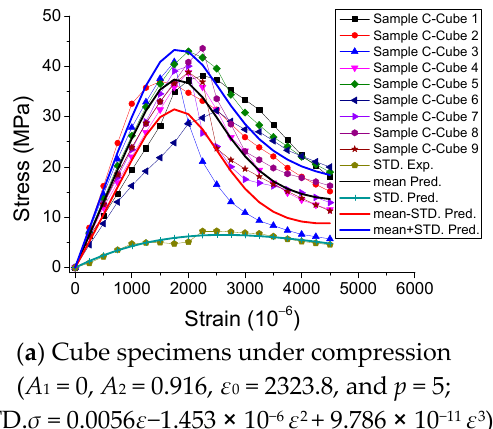
Sample C-Prism 4 Sample C-Prism 5 Sample C-Prism 6 Sample C-Prism 7 Sample C-Prism 8 STD. Exp. mean Pred. STD. Pred. mean-STD. Pred. mean+STD. Pred.